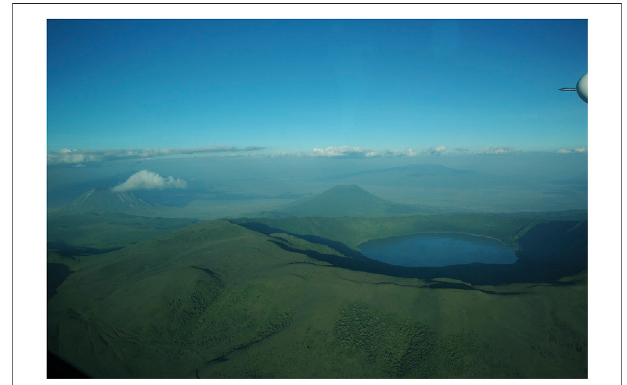
FIGURE 7 | Lake Empakaai (seen from the southwest), Northern Tanzania (picture by B. Fontaine). Volcanoes in the back are Oldoinyo Lengai (left) and Kerimasi